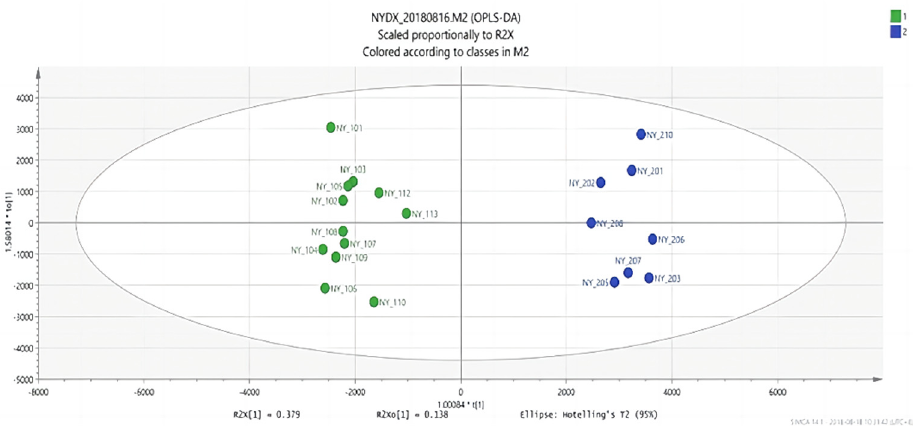
Figure 6. OPLS-DA score plots between group 1 and group 2.